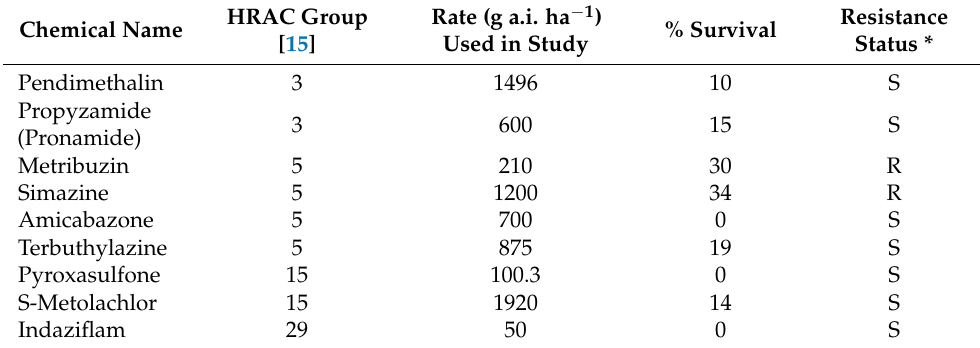
Table 4. Rate of herbicides used and survival (%) of the field population SA1 to herbicides at PRE application in a pot